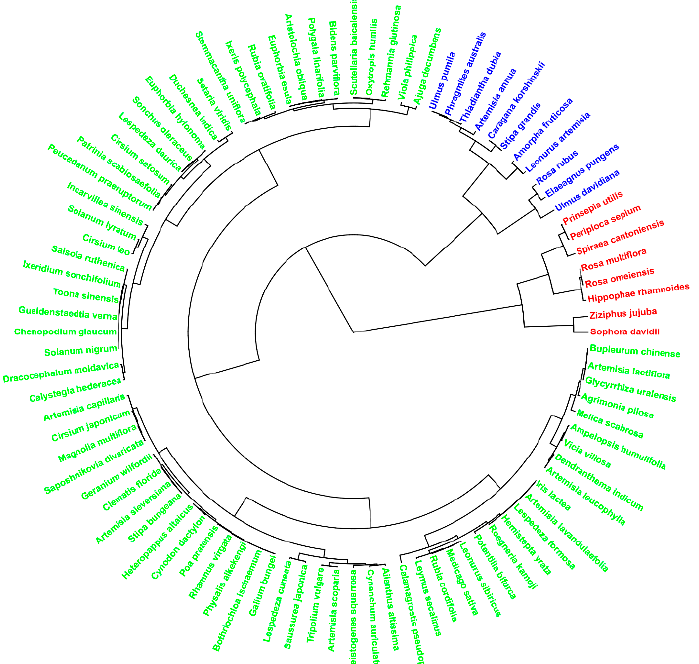
Figure 2. Hierarchical clustering of understory species based on average height. The same color represents the same group.